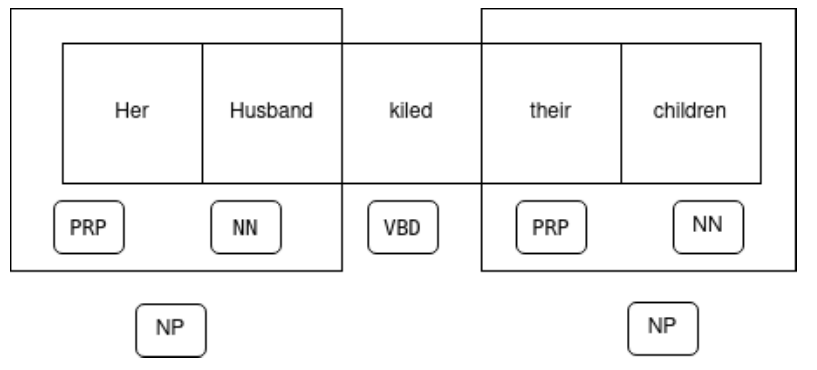
Figure 2. Bunching of noun